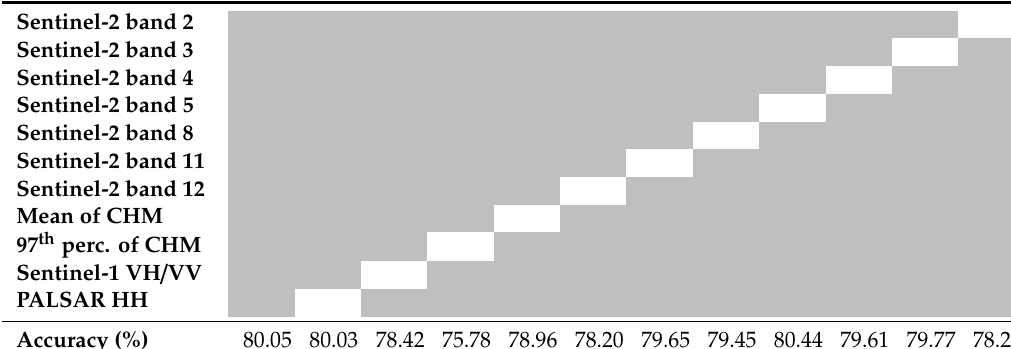
Table 1. Five-fold cross-validation accuracy (100 repeats) of predicted forest physiognomic types from support vector machine classification by leaving out one from all the significant bands (i) Sentinel-2 spectral bands (2,3,4,5,8,11,12), (ii) mean and 97th percentile of canopy height model, and (iii) Sentinel-1 VH / VV and PALSAR HH bands. Grey shade shows which bands were used.